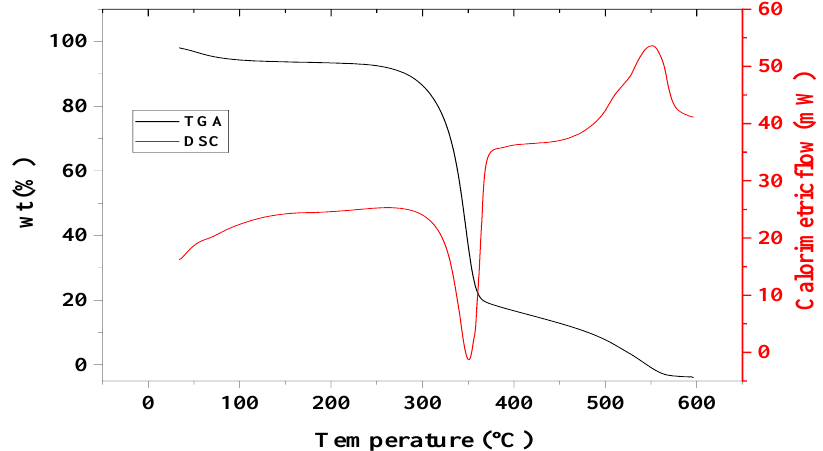
Figure 1. Thermal stability analysis of the cellulose extracted from the corn stalks.